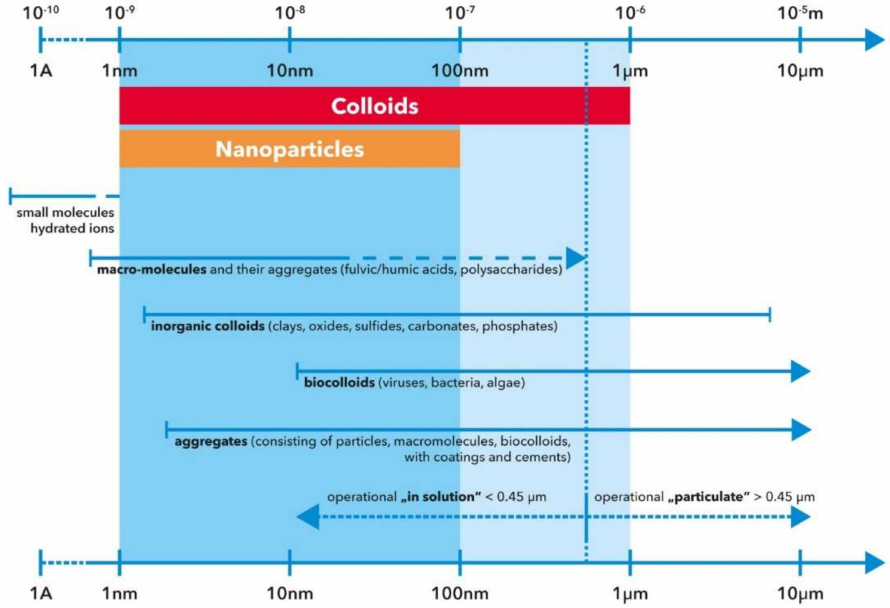
Figure 1. Dimensional classes of natural colloids and NPs. Adapted from Christian et al.